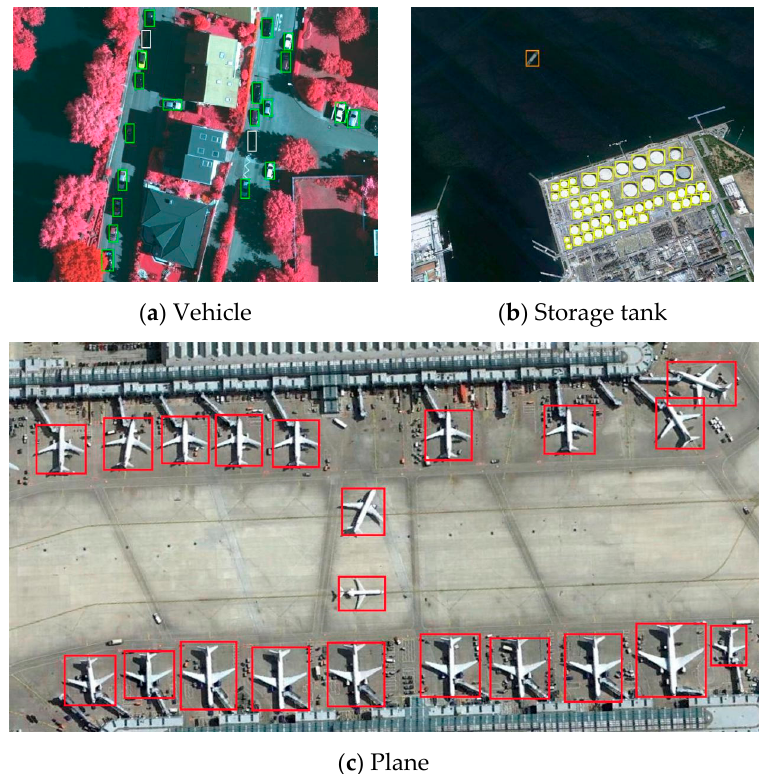
Figure 2. Some examples of detection results predicted by our proposed model. Image ( a – c ) are the detection results of vehicle, storage tank, and plane. The white boxes in the picture ( a ) indicates the targets of missed detection.